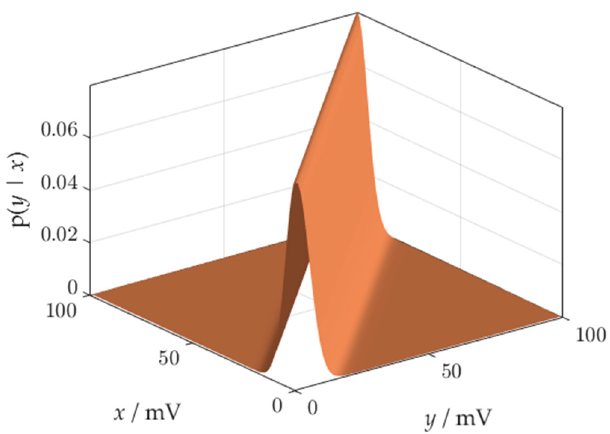
Figure 2. A probability density function governing the sensor process.